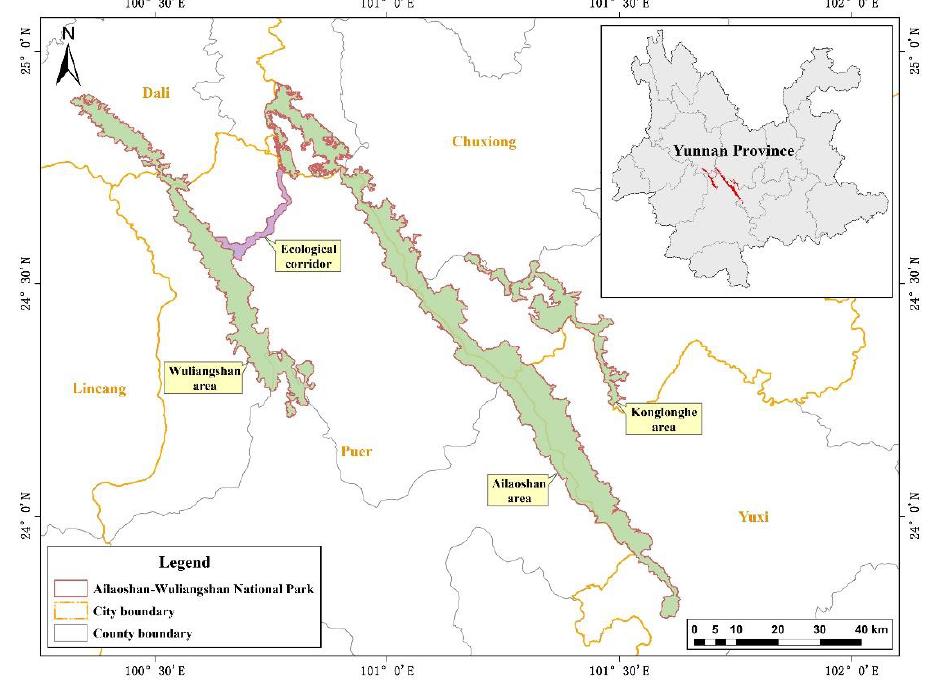
Figure 1. The study area